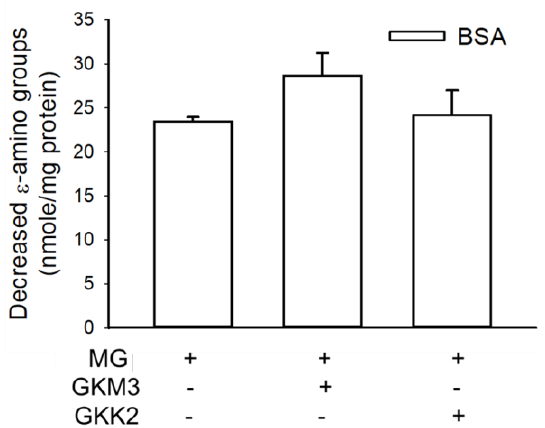
Figure 5. Effect of GKM3 and GKK2 on the content of ε -amino groups of products in the final stage of protein glycation. Data unit was expressed as the decreased nmole of ε -amino groups per mg of protein of samples. Data shown are means of results calculated by values of native BSA groups minus values of glycated BSA groups obtained from three independent experiments.